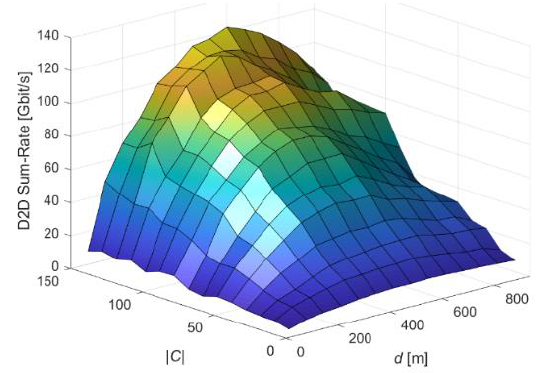
Figure 19. The impact of varying the maximum allowable D2D distance (i.e., 𝑑 ) and the total num- ber of available channels in each macrocell (i.e., |Ϲ| ) on the achievable sum of D2D rates (i.e., 𝑅 𝑡𝑜𝑡𝑎𝑙D2D ).